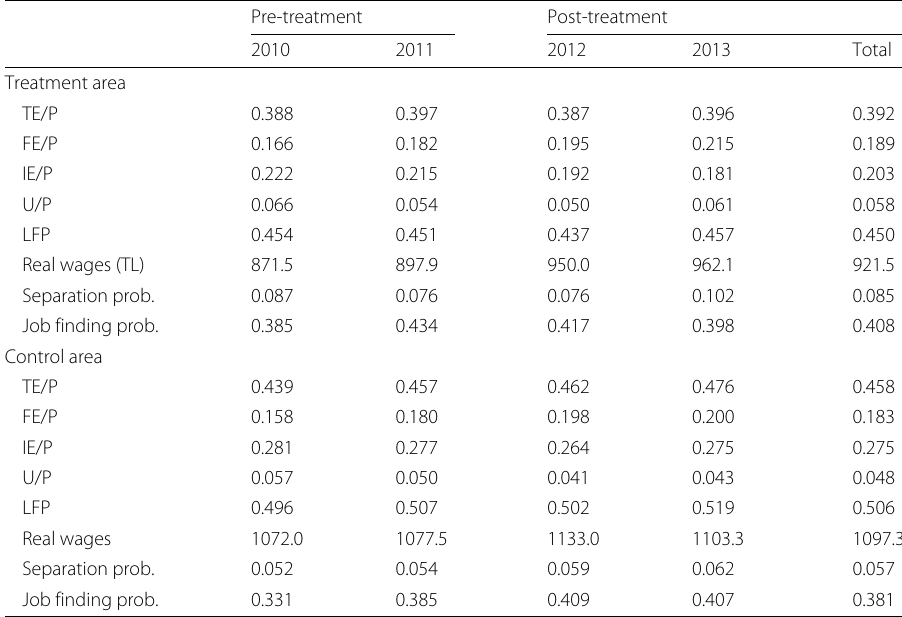
Table 4 Summary statistics: labor market outcomes for